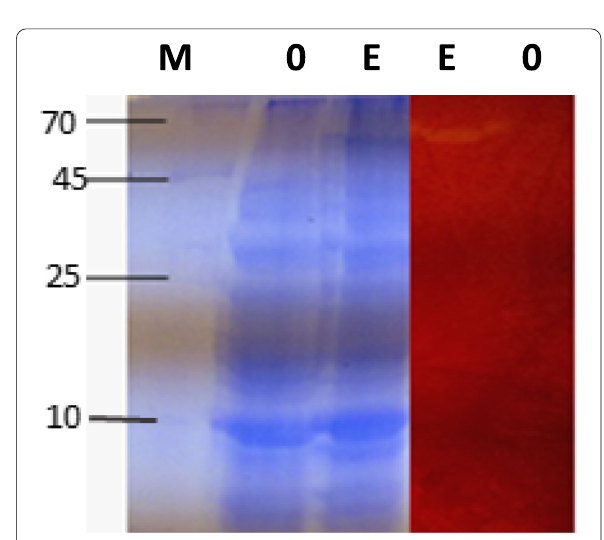
Fig. 5 SDS‑PAGE (12%) and activity staining (zymogram) for cellSNSY recombinant clone 1 (cell lysate). Lane M: protein marker, left side (stained with Coomassie stain) and right side (zymogram). Lane 0, E: non‑induced and IPTG induced recombinant cellSNSY samples, after 24‑h incubation in LB amp broth,